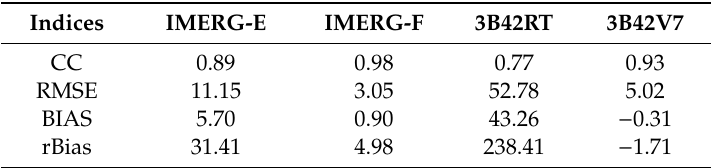
Figure 7. Distribution of monthly precipitation estimates obtained for the in situ rain gauges and four satellite precipitation products (IMERG-E, IMERG-F, 3B42V7, and 3B42RT) over the Tianshan Mountains in the northwestern China. Table 2. Summary of performance evaluation metrics of monthly precipitation estimates from IMERG-E, IMERG-F, 3B42V7, and 3B42RT products over the Tianshan